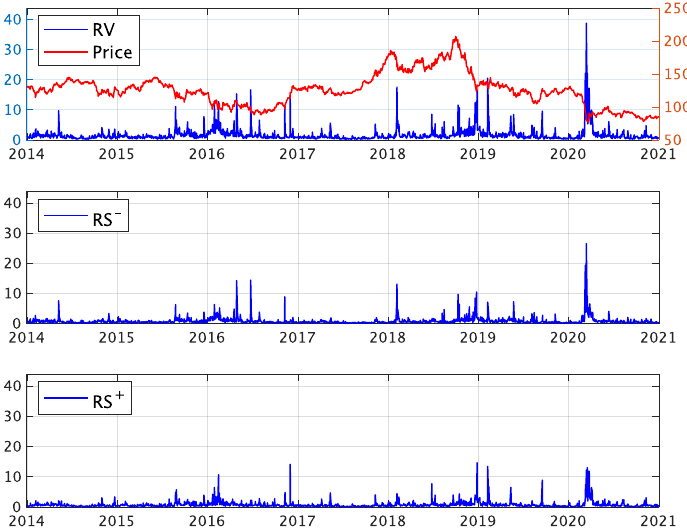
Figure 1. The daily price, realized volatility, and realized semivariance of the energy resource